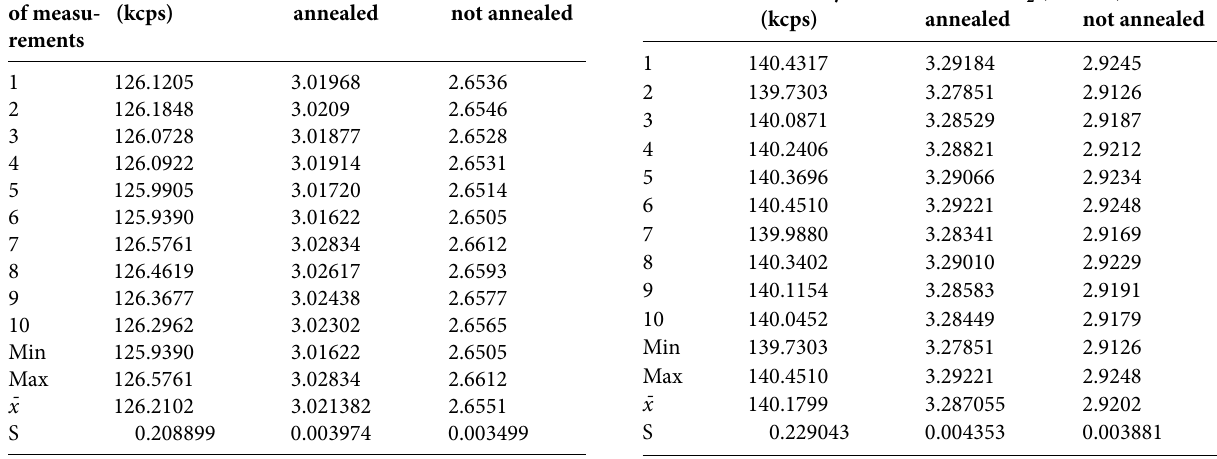
Table 11. The content of TiO 2 in the reference bauxite sample B 010 calculated using the XRF method (by pressing)